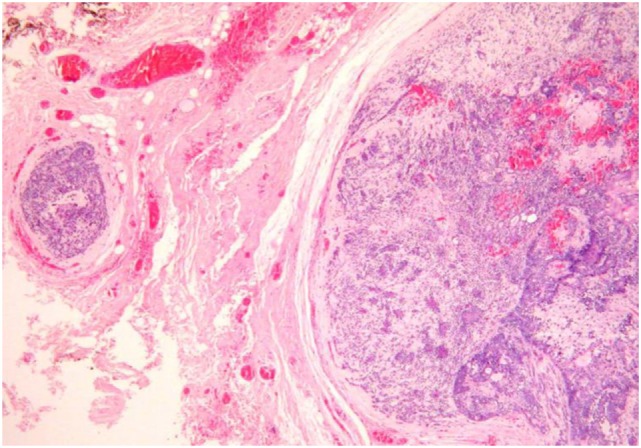
Satellite nodules.